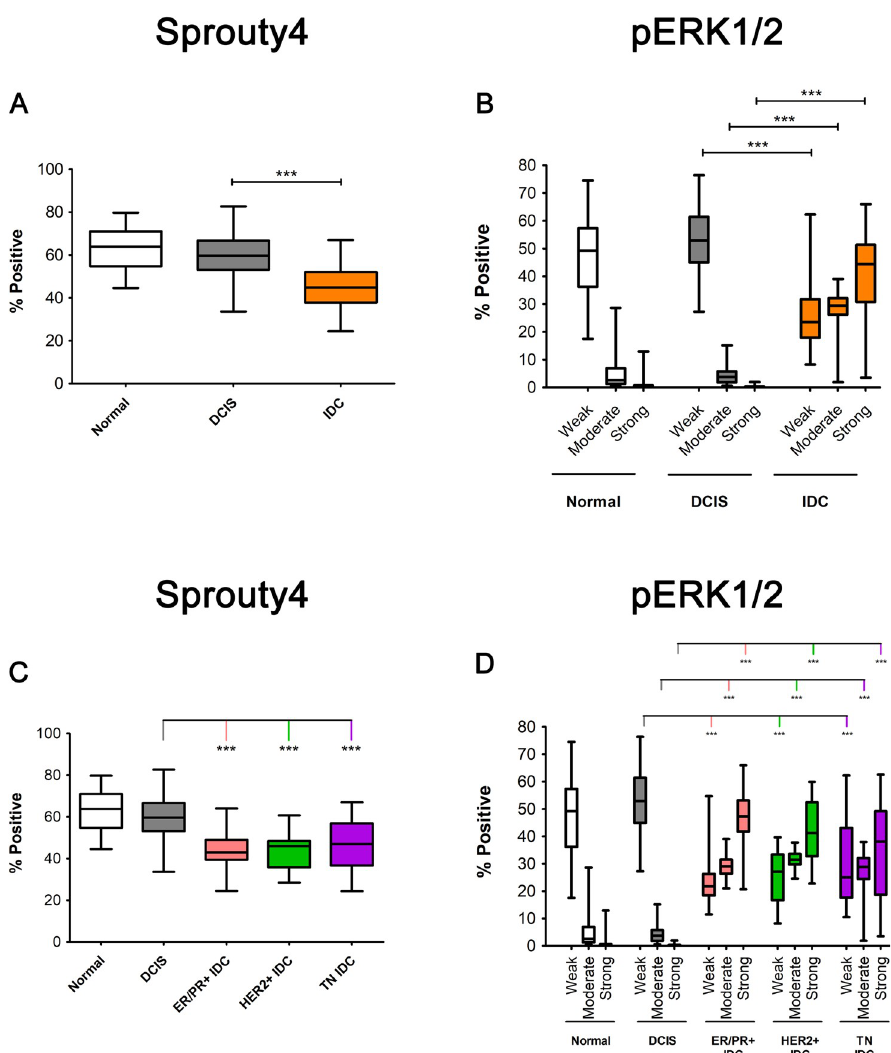
Fig 1. Sprouty4 levels are significantly reduced in human IDCs relative to normal and DCIS tissues whereas phosphorylated ERK1/2 shows the opposite pattern. Human tissue microarrays (TMAs) containing samples of normal breast tissue adjacent to tumor, n = 24; DCIS, n = 45; and IDC, n = 169; were processed for IHC using optimized protocols and antibodies for Sprouty4 and phosphorylated ERK1/2 (pERK1/2). (A, C) One-way ANOVA employing Tukey’s multiple comparison test showed significant differences in the percentage of cells that were positive for cytosolic Sprouty4 expression when comparing normal or DCIS tissue to IDC that was pooled or separated by subtype ( α = 0.001, 99.9% CI; ��� p < 0.001). Whiskers represent the minimum and maximum values and bars represent the median. (B, D) A Kruskal-Wallis test employing Dunn’s test of multiple comparisons showed significant differences in the percentage of cells that were positive for pERK1/2 expression when comparing normal or DCIS tissue to IDC that was pooled or separated by subtype ( α = 0.001, 99.9% CI; ��� p <